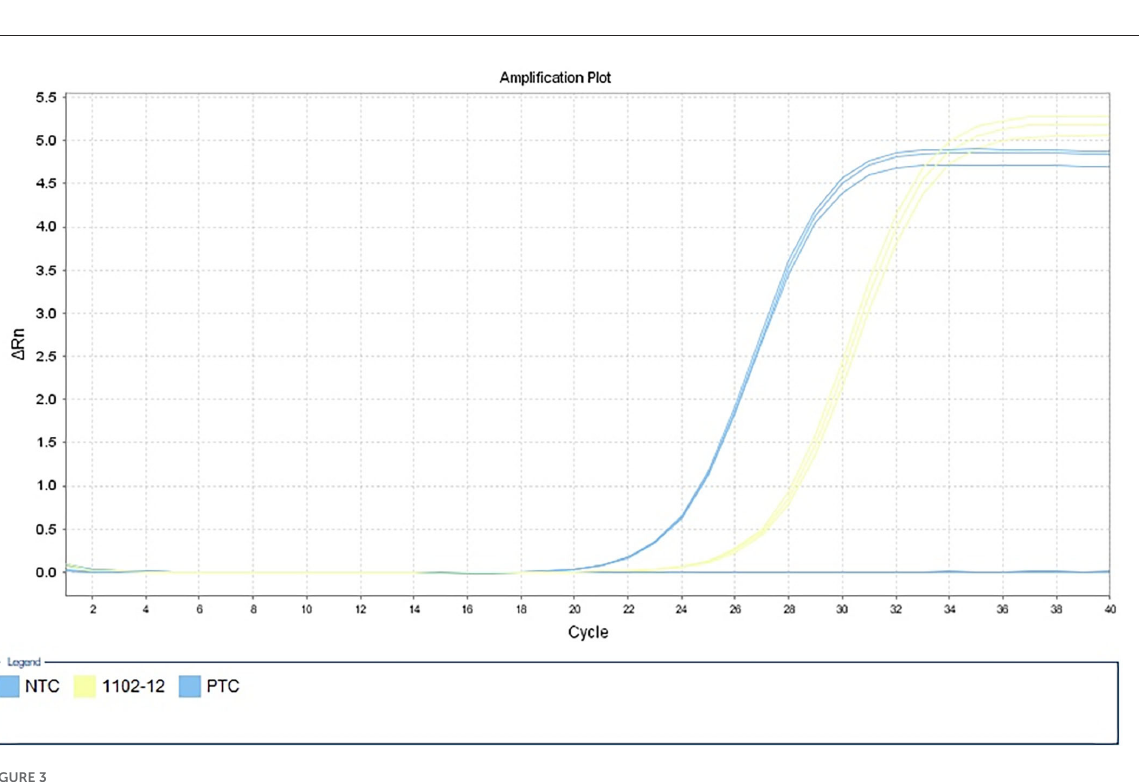
weakness is the main symptom. In other subtypes, patients show cranial nerve function defects, especially bilateral facial muscle weakness, dysphagia, or extraocular muscle dyskinesia. Some